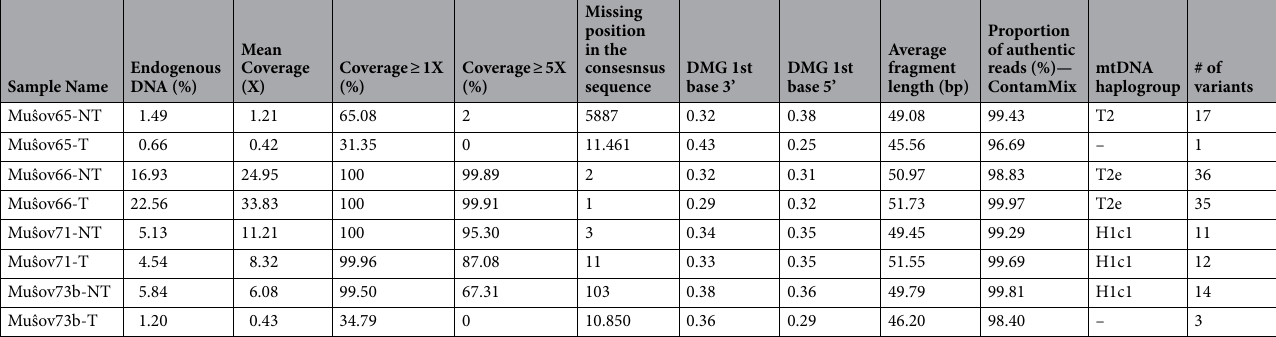
Table 2. Results of the analysis performed on the mitochondrial DNA recovered from the untreated (NT) and treated (T) bone samples coming from the Longobard site of